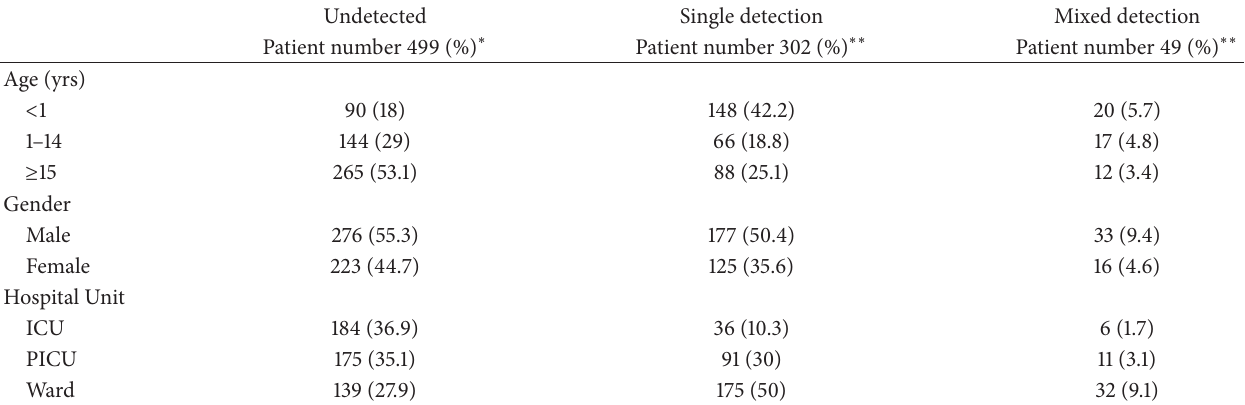
Table 3: Distribution of patients with undetected, single, and mixed detection in relation to age, gender, and hospital admission. Undetected Single